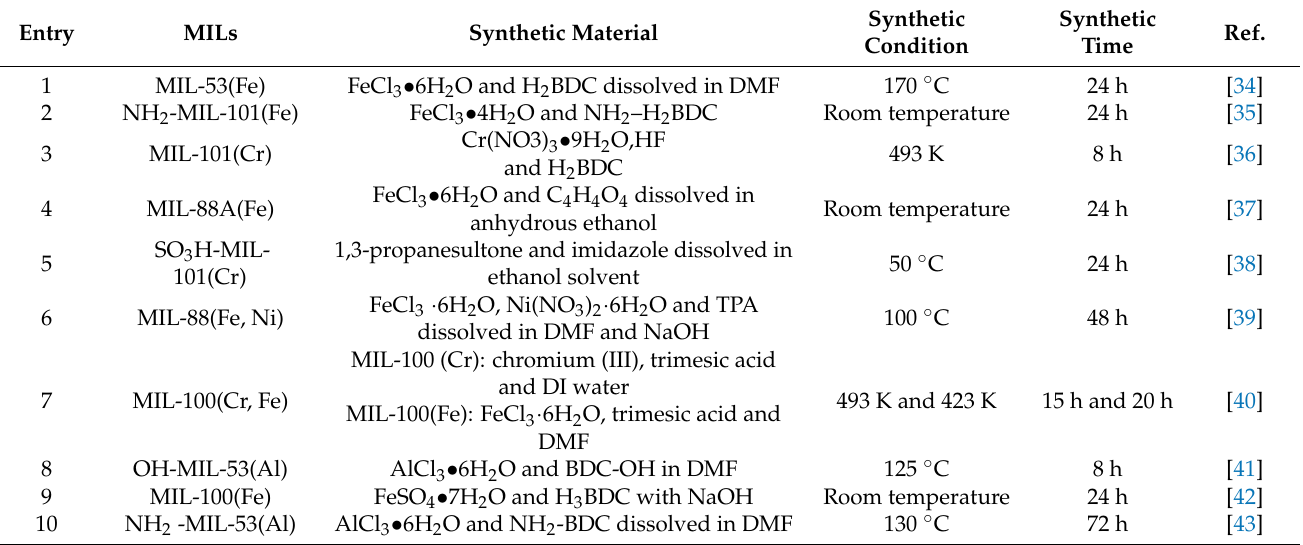
Table 1. Summary of information of MILs compounded by hydrothermal